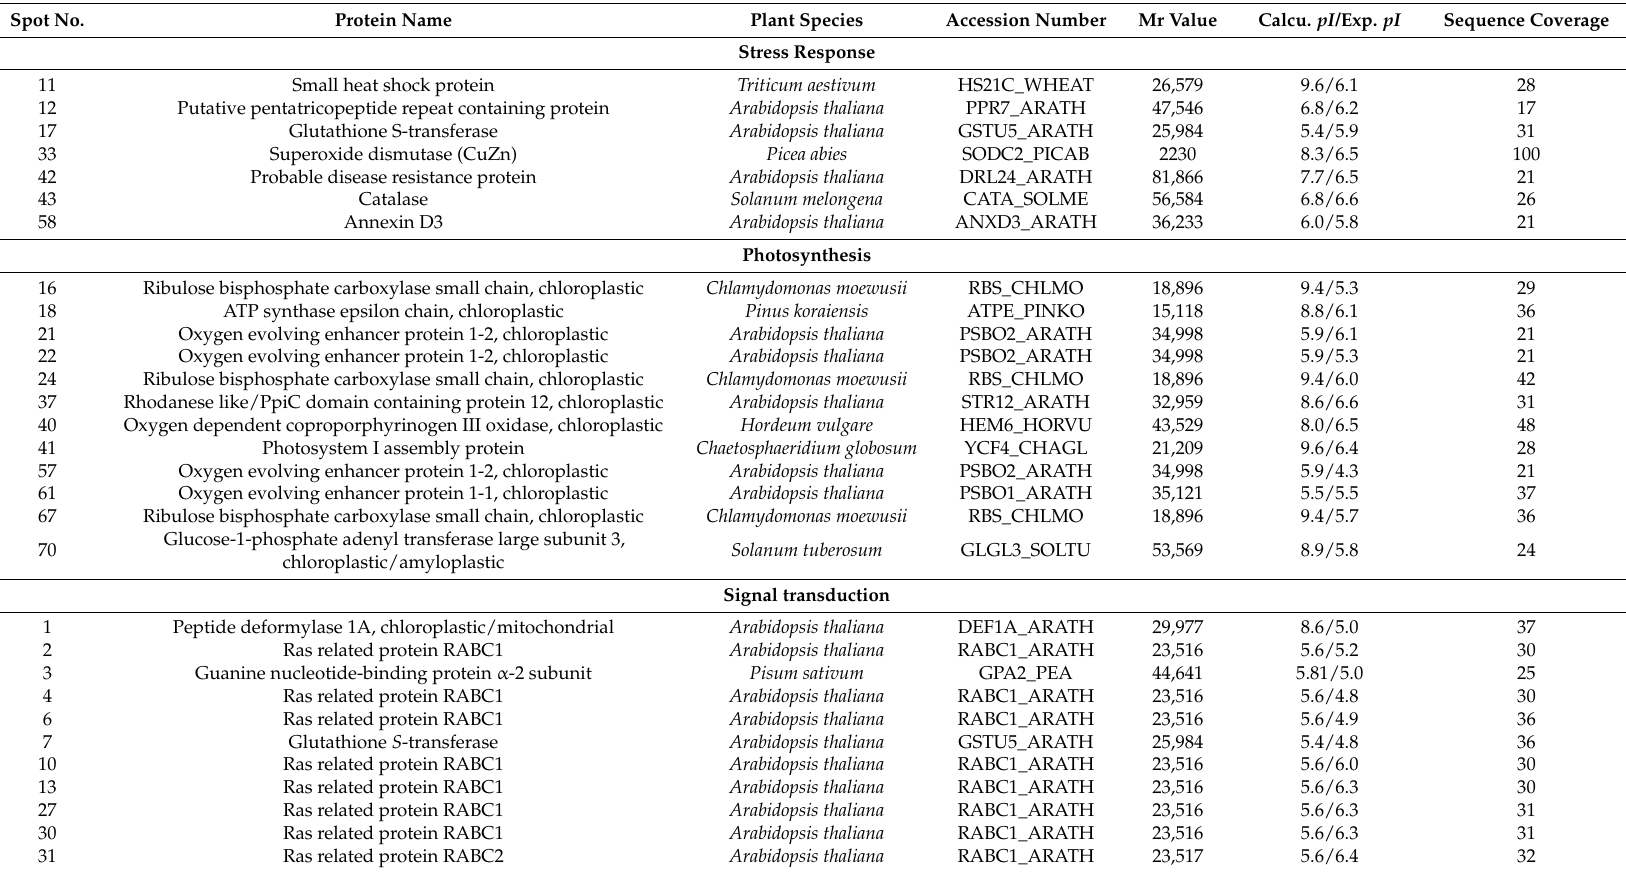
Table 1. Protein identification in carnation under Si and hyperhydric treatments analyzed by MALDI-TOF MS. Spot